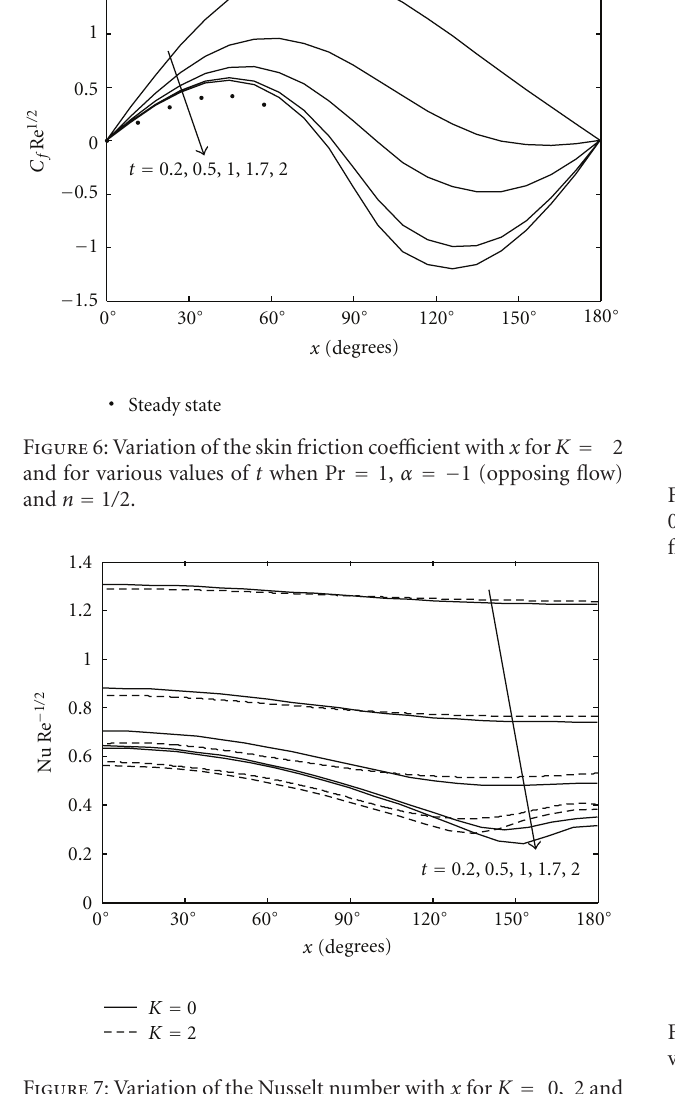
Figure 7: Variation of the Nusselt number with x for K = 0, 2 and for various values of t when Pr = 1, α = 1 . 25 (assisting flow) and n = 0.